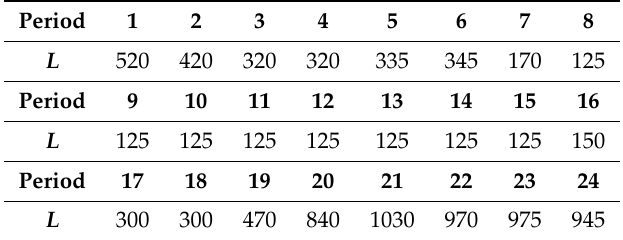
Table 2. Power demands (MW)-scenario 2. Data from [11].